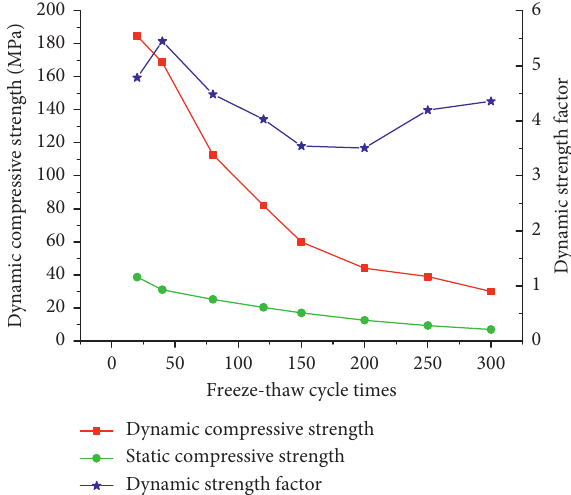
Figure 13: Curves of static and dynamic compressive strength and dynamic strength factor of sandstone with the number of freeze- thaw